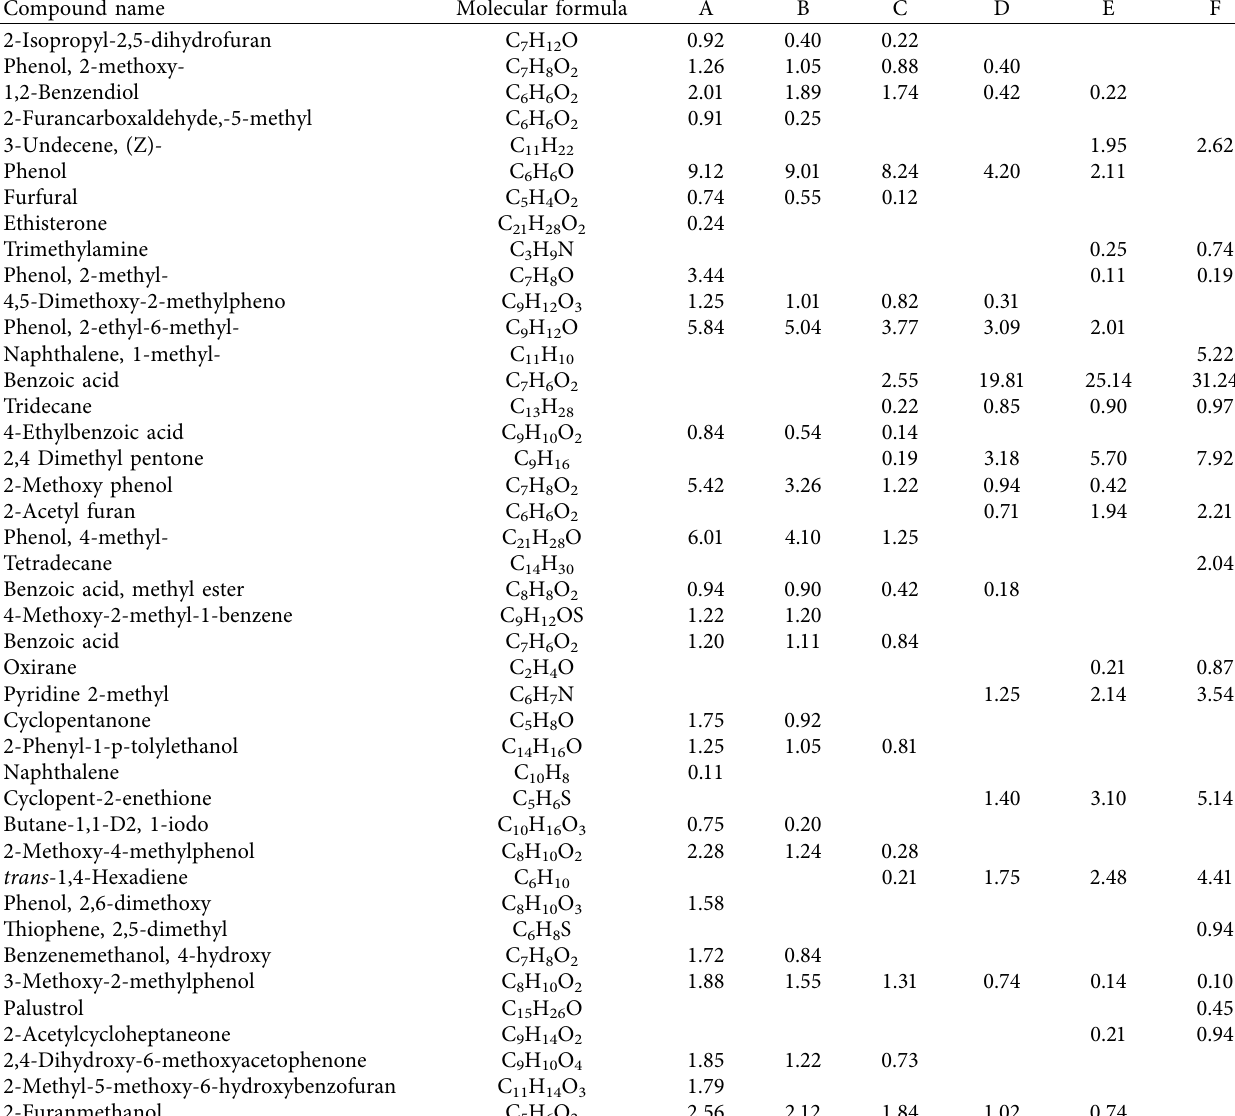
Table 3: List of chemical elements identified in liquid oils through